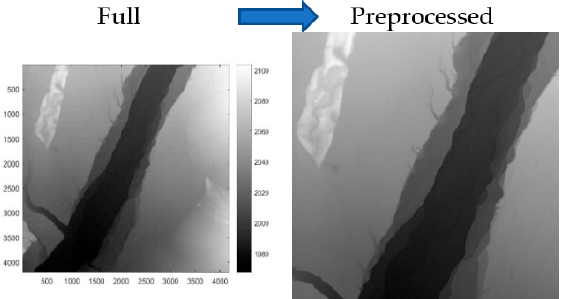
Figure 4. Braided riverbed (Jackson Hole, WY, USA) [64]: 1000 × 1000 with pixel size of 6 m.